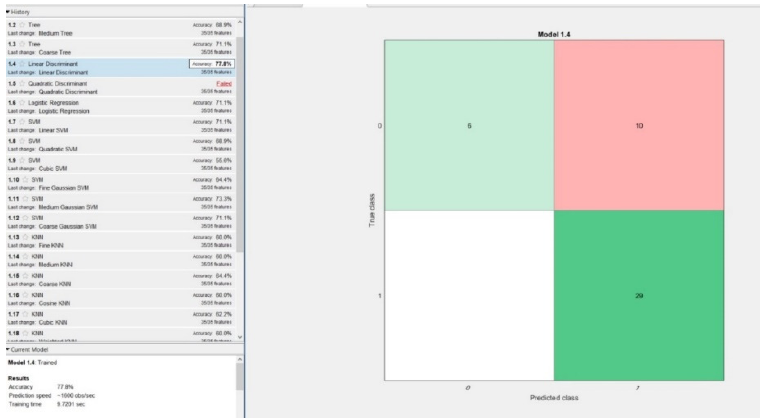
Figure 6. Best performing model obtained using 5% hold out validation: linear discriminant. 15% of Data Held out for